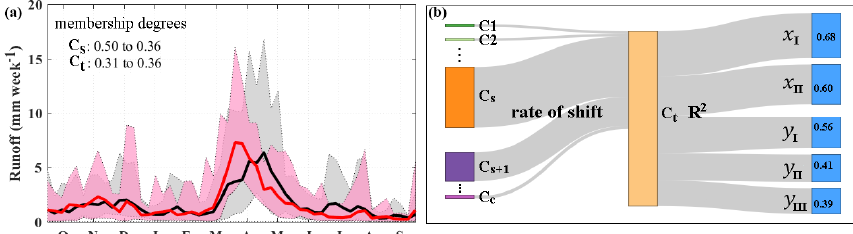
Figure 4. An example for transitions between regime types along with attribution of change to streamflow characteristics. Panel (a) shows annual hydrographs in two separate periods using grey and pink envelopes. Panel (b) shows the dominant shift in the flow regime by maximum rate of shift and attributes this shift to changes in significantly dependent streamflow characteristics. The dominant shift is visualized by the thickest grey envelope. The strength of the association between regime shift and significantly dependent streamflow characteristics are measured and communicated by R 2